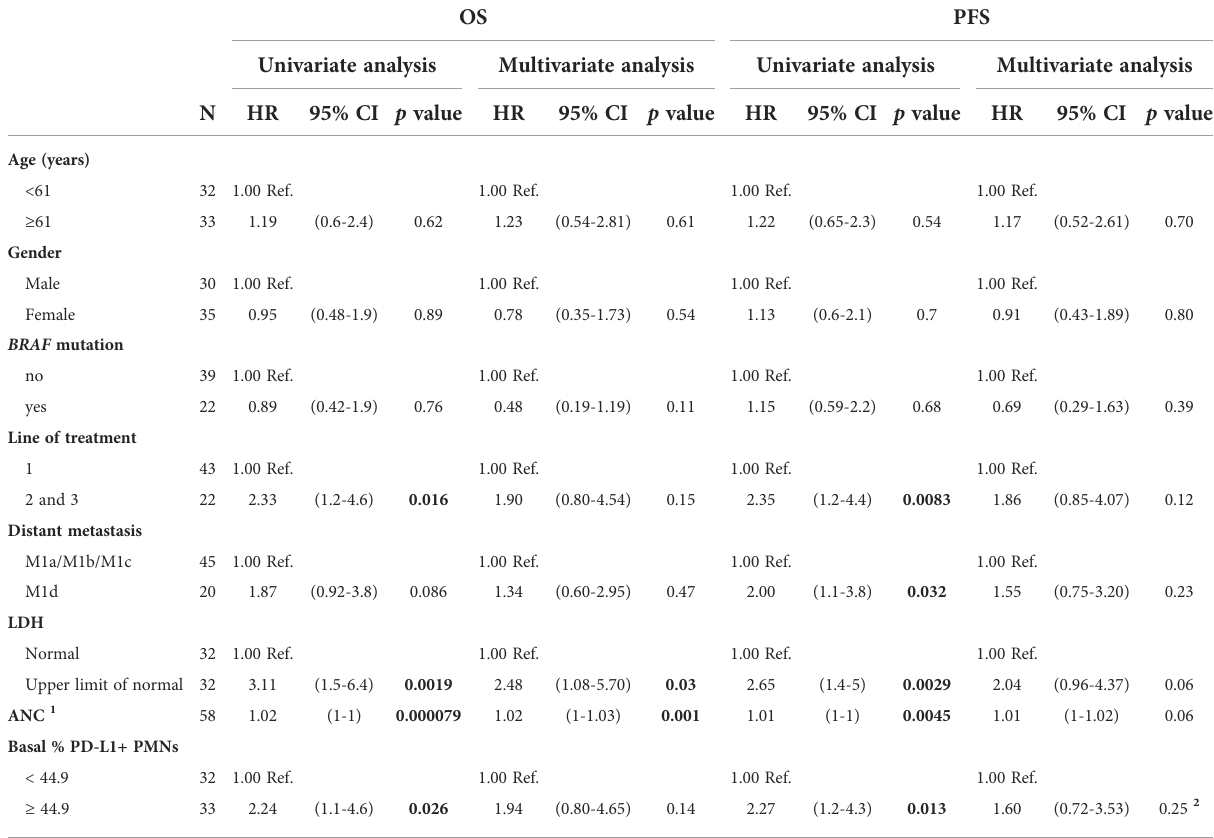
TABLE 1 Univariate and multivariate analyses for OS and PFS in advanced melanoma